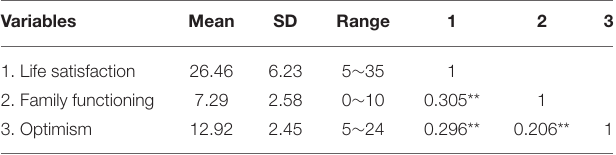
TABLE 2 | The correlations of life satisfaction and continuous variables ( N =